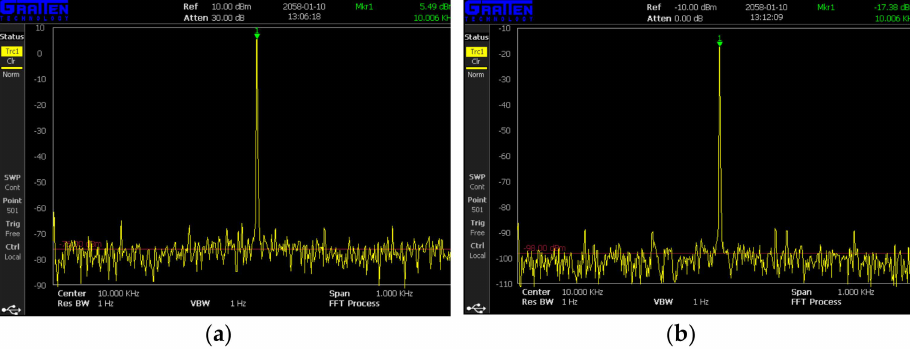
Figure 14. Test result of 10 KHz sine wave SNR. ( a ) Signal power test. ( b ) Noise power